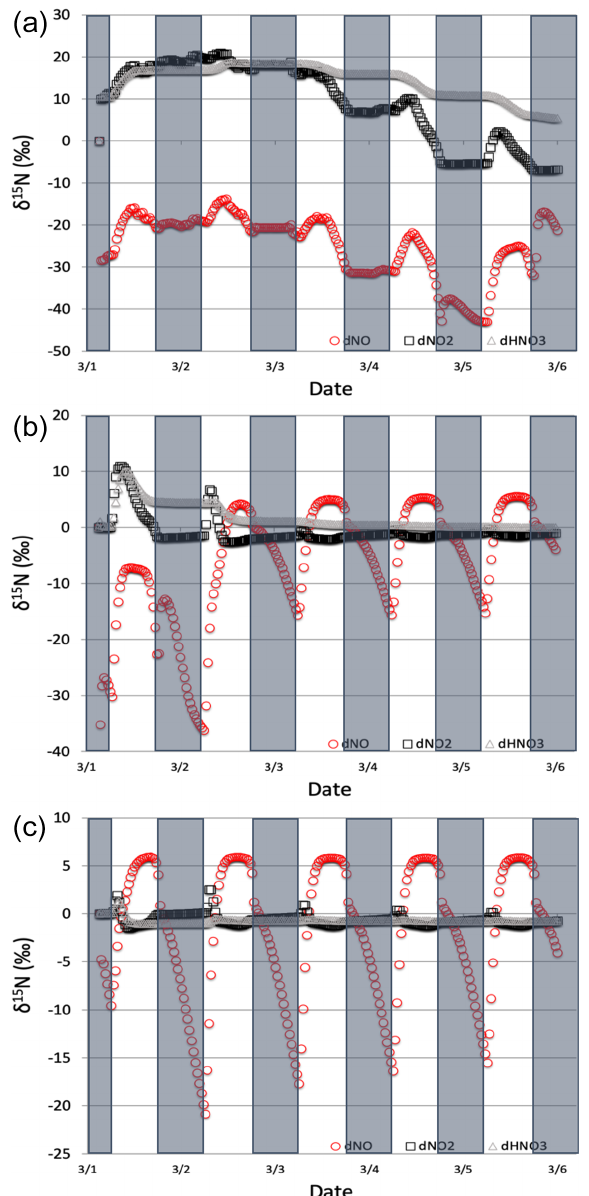
Figure 9. The δ 15 N values of NO x and HNO 3 when isotope effects in Reactions (R1), (R48), and (R238) are included under high (a) , medium (b) , and low (c) NO x scenarios. The 5d simulation was under the conditions list in Table S3d–f. The NO y δ 15 N values are mainly controlled by NO x isotope exchange (Reactions R238) un- der high NO x conditions and Leighton (Reactions R1 and R58) un- der low NO x conditions.